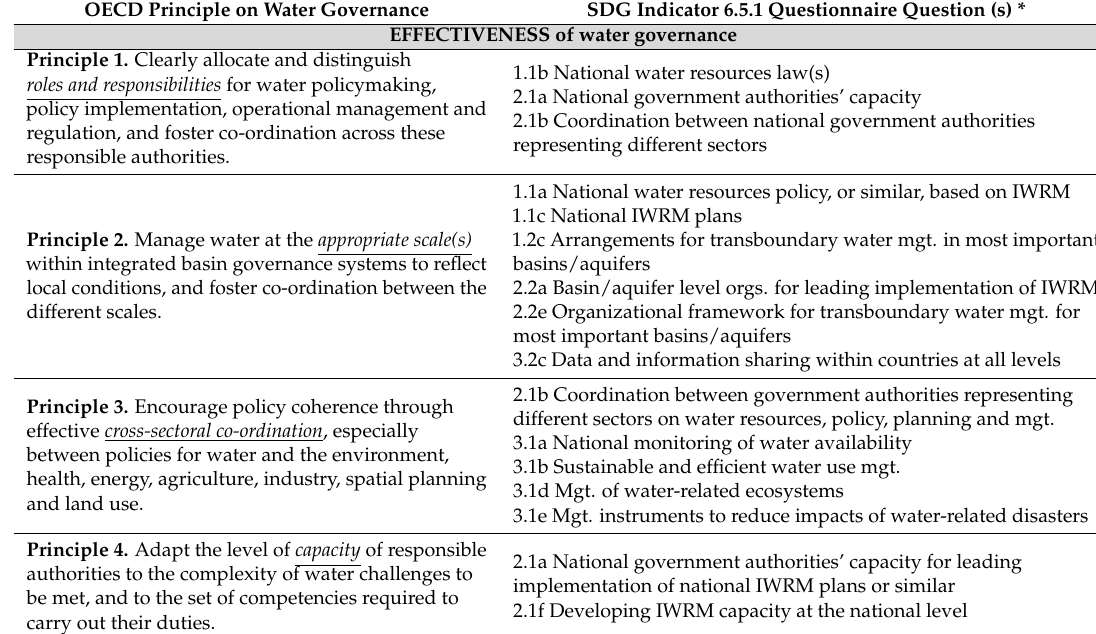
Table 1. SDG indicator 6.5.1 survey questions supporting measurement of OECD governance